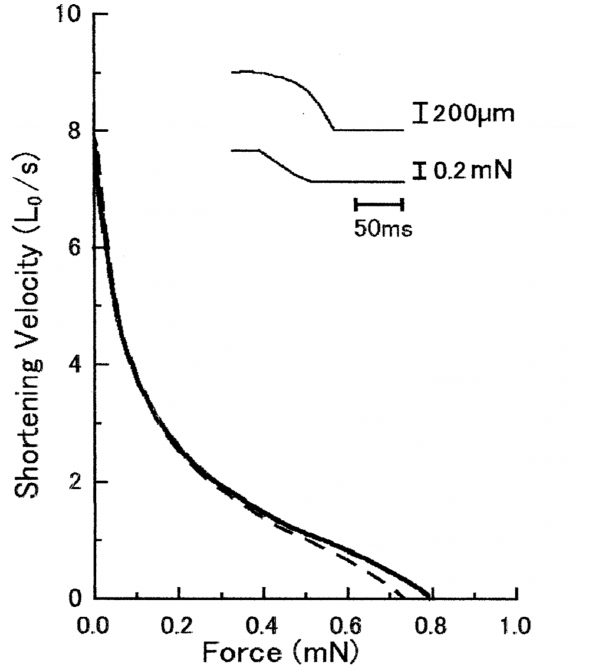
Figure 3. No appreciable effect of anti-CAD antibody on force- velocity curves of Ca 2 + -activated muscle fiber. In this and Fig. 5, solid and broken lines indicate force-velocity curves before and after application of anti-CAD antibody (2 mg/ml), respectively. Inset shows an example of fiber length (upper trace) and force (lower trace) changes in response to a ramp decrease in force.